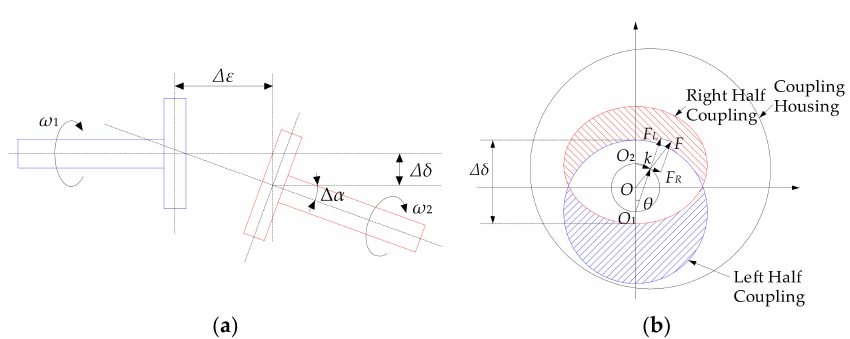
Figure 4. The model for the misalignment rotor: ( a ) the misaligned rotor; ( b ) exciting